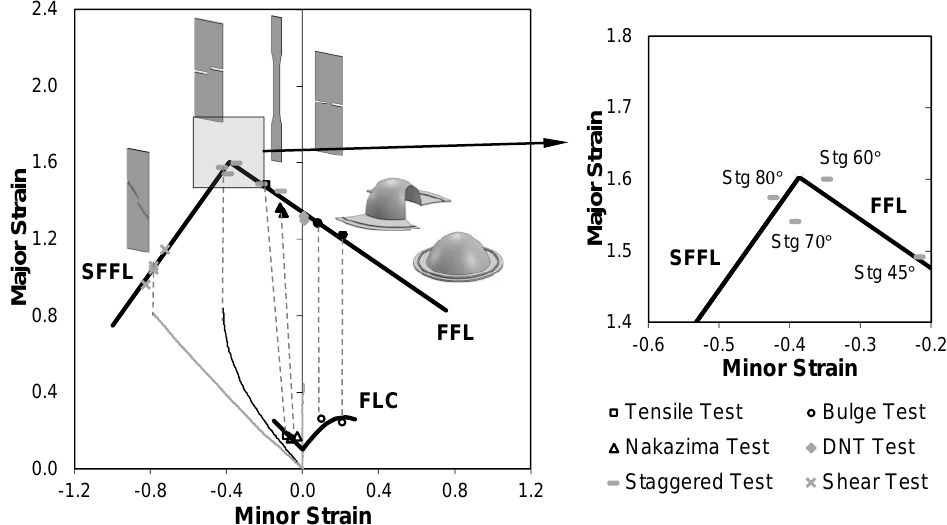
Figure 5. Failure loci (forming limit curve (FLC), FFL and SFFL) of aluminium AA1050-H111 sheets with 1 mm thickness. The solid and open markers correspond to strains at fracture and necking, respectively.